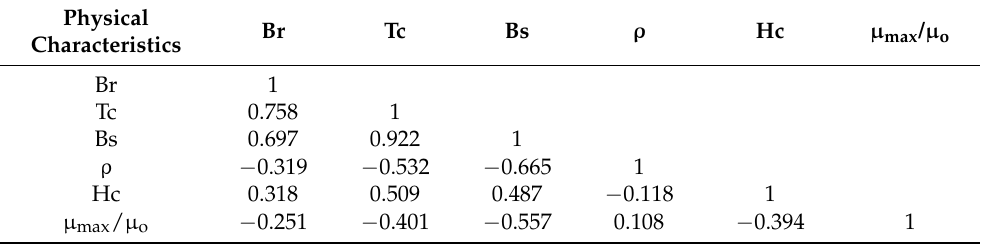
Table 4. Pearson correlation matrix of physical